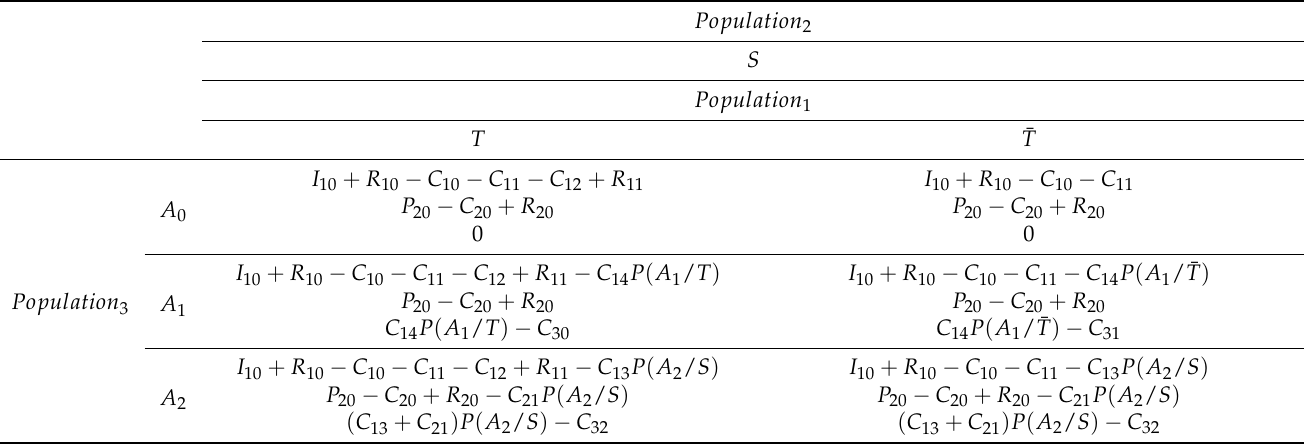
Table 3. Payoffs for the proposed